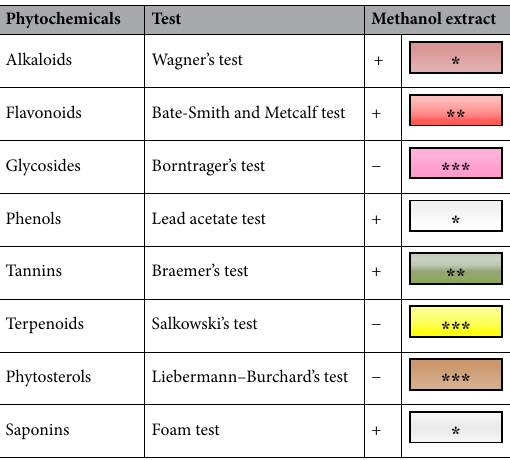
Table 1. Phytochemical constituents of Withania somnifera roots methanol extract. ‘+’ indicates presence; ‘−’ indicates absence; ‘colors’ indicate the precipitate simulation color for presentness; ‘*’ indicates reactions within 5 min; ‘**’ reactions in 5–20 min; ‘***’ no-reaction up to 24